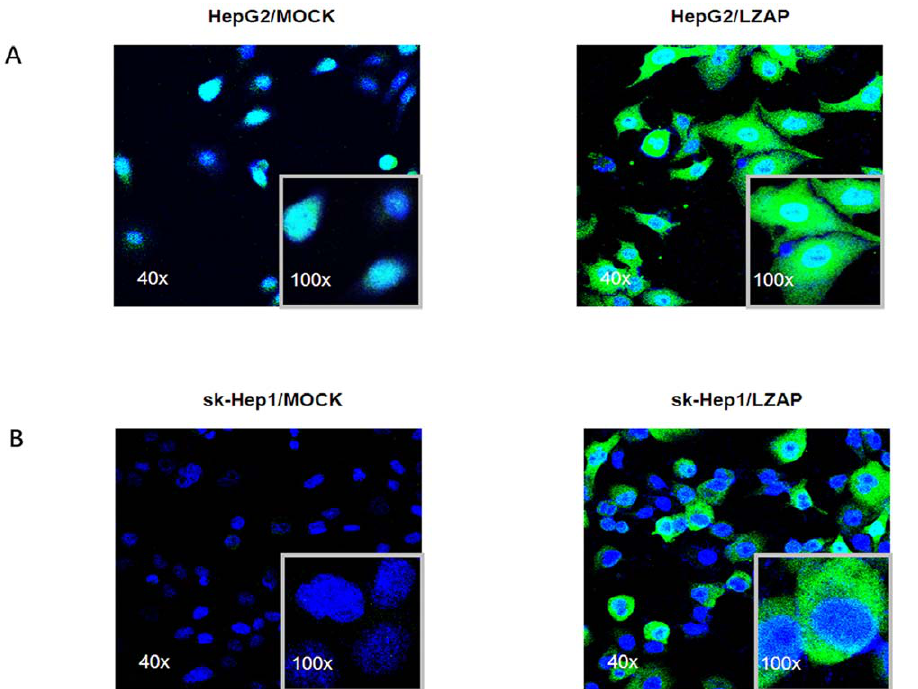
Figure 4. LZAP protein expression in the HepG2 and sk-Hep1 cells infected with Ad-control and Ad-LZAP. ( A ) The LZAP expression (green, mainly in the cytoplasm) in the HepG2 cells infected with Ad-LZAP was strikingly higher than that that in the cells infected with the Ad- control. ( B ) The LZAP expression (green, in the cytoplasm) was also higher in the sk-Hep1 cells infected with Ad-LZAP than in the sk-Hep1 cells infected with the Ad-control. The cell nuclei (blue) were stained with DAPI. 40 6 magnification. Inset: 100 6